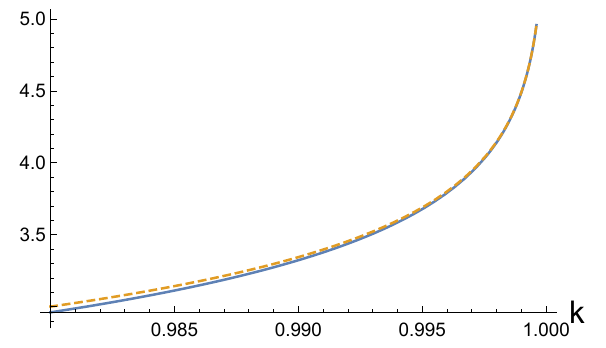
√ 1 − k 2 ) (dashed line).